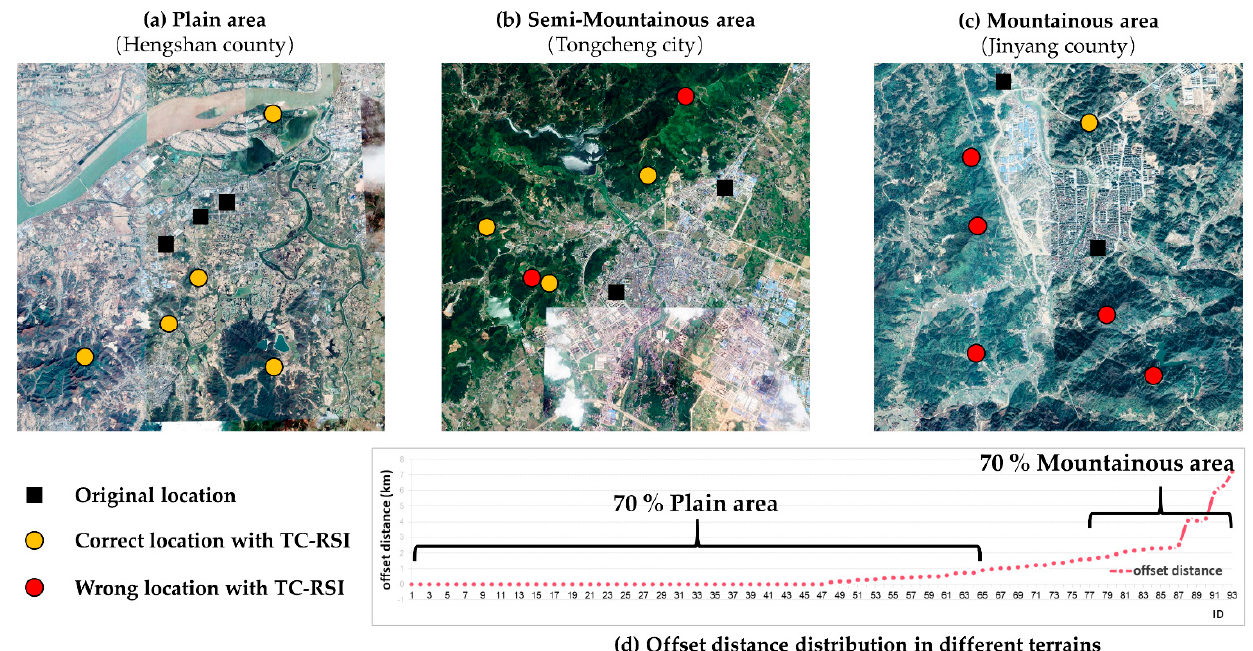
Figure 9. Terrain impacts the TC-RSI method. ( a ) Corrected locations in the plain area. ( b ) Corrected locations in a semi-mountainous area. ( c ) Corrected locations in a mountainous area. ( d ) Offset distance distribution in different terrains in An’hui province. Note that Hengshan county, Tongcheng city, and Jinyang county belong to the experimental dataset in An’hui.